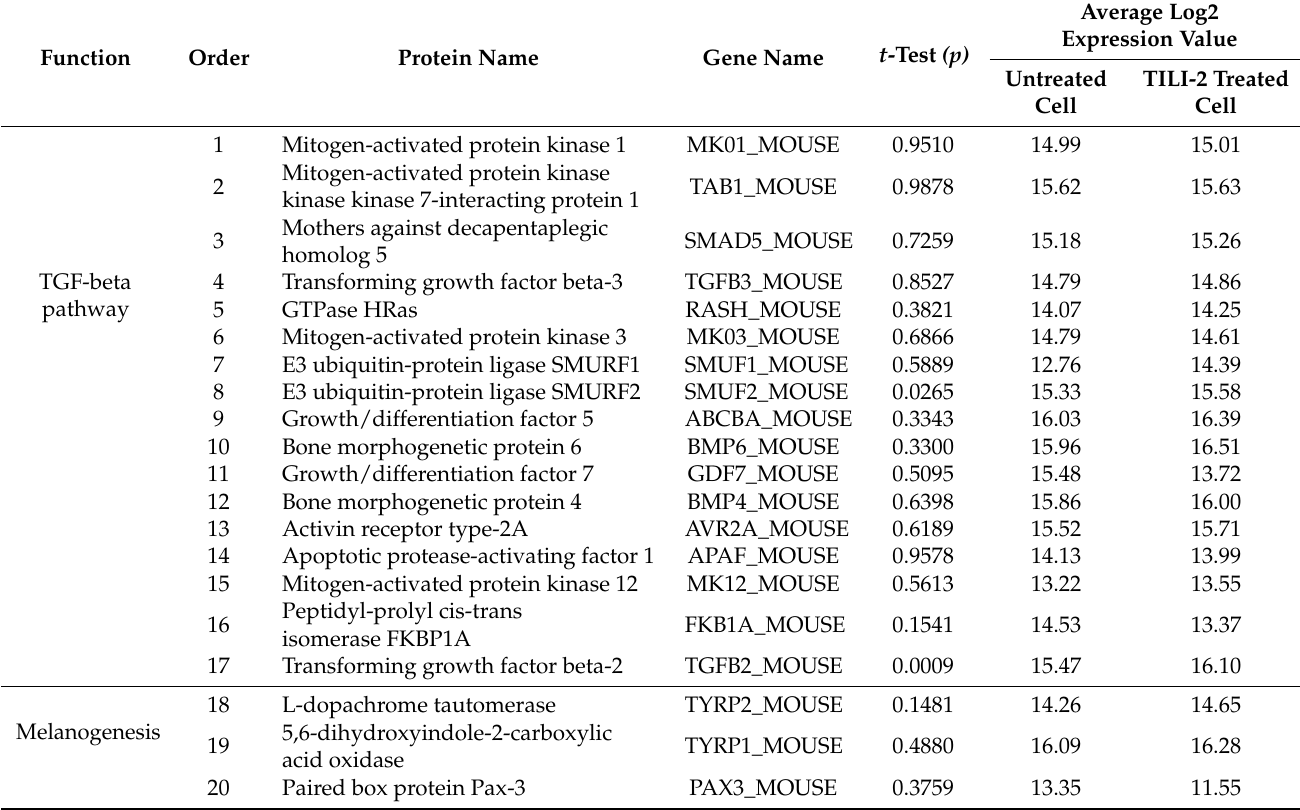
Table 4. The relative quantitation ratios (log2) of proteins in the TGF beta signaling pathway and proteins involved in melanogenesis upon treatment with TILI-2 from proteomics